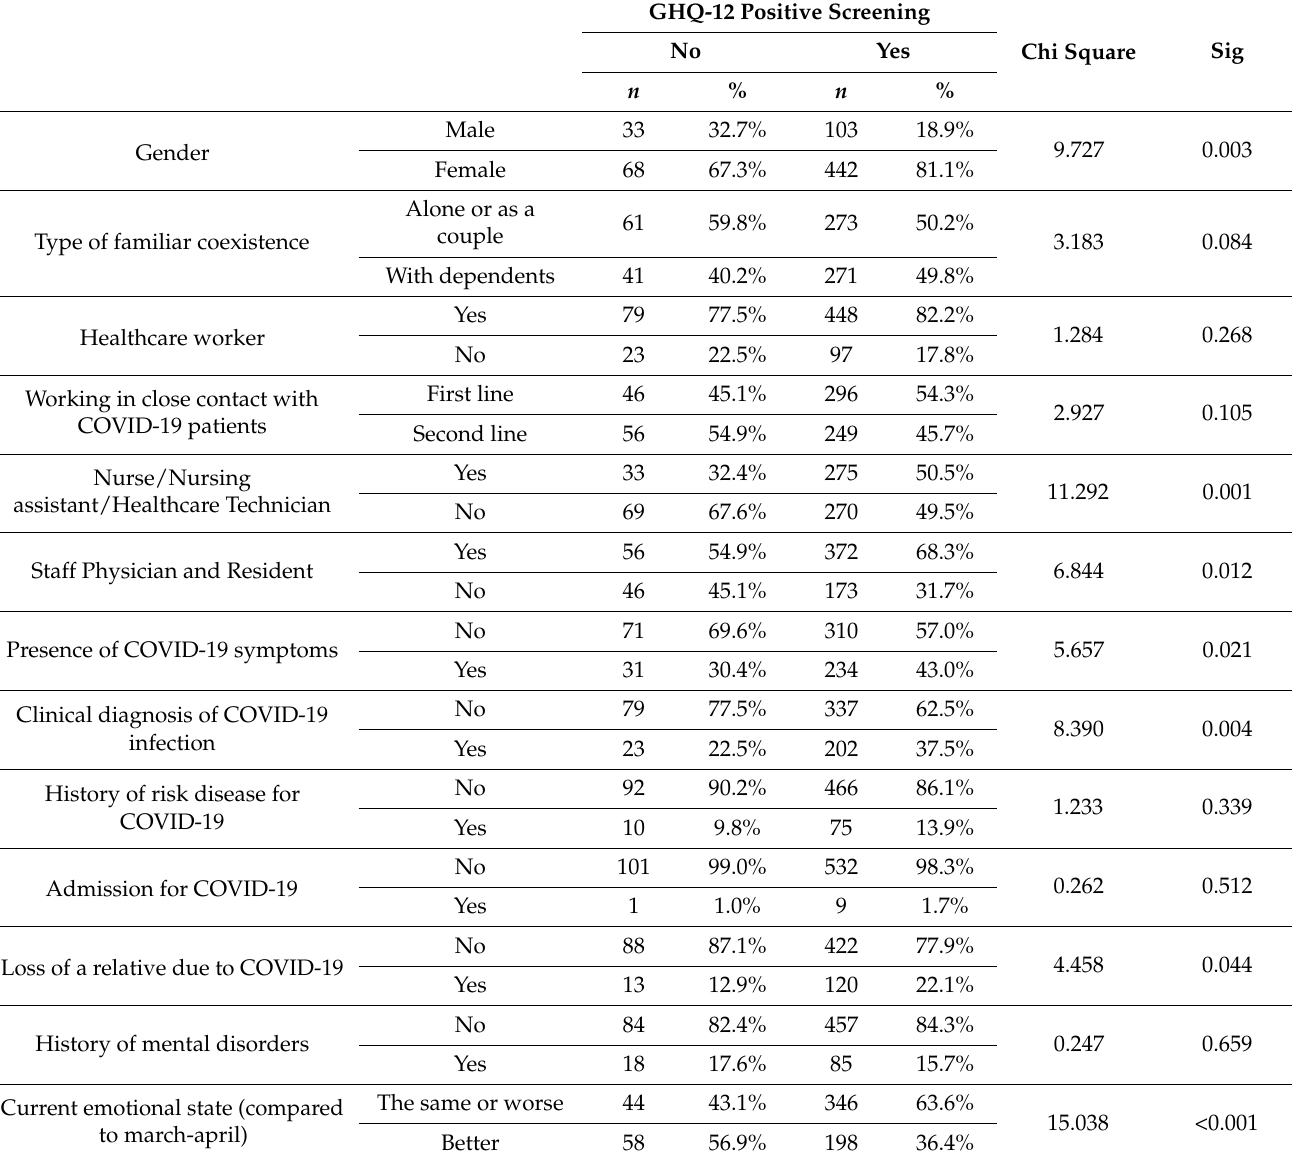
Table 1. Bivariate analysis results: sociodemographic, health, and professional variables. GHQ-12 Positive